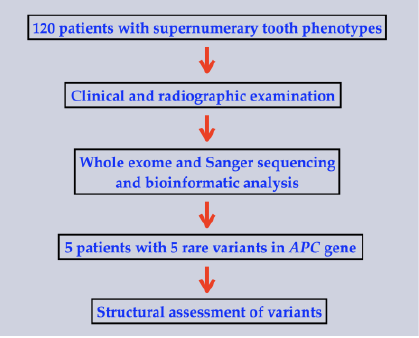
Figure 6. Flowchart describing the methodology of the study. Regarding 93 patients with mesiodentes, 63 (68%) were males and 30 (32%) were fe‑ males. Seventy‑seven patients (82.8%) had single mesiodentes, while 16 (17.2%) of them had double mesiodentes. The orientation of the mesiodentes was noted in 63 mesiodentes of 53 patients; 42 (66.7%) of them had normal orientation, 20 (31.7%) were inverted, and 1 (1.6%) had transverse orientation. The eruption status had been noted in 59 mesiodentes of 48 patients: 31 (52.5%) erupted and 28 (47.5%) were unerupted. For the patients with isolated supernumerary teeth that were not mesiodens or mesiodentes, the information of the supernumerary teeth was not